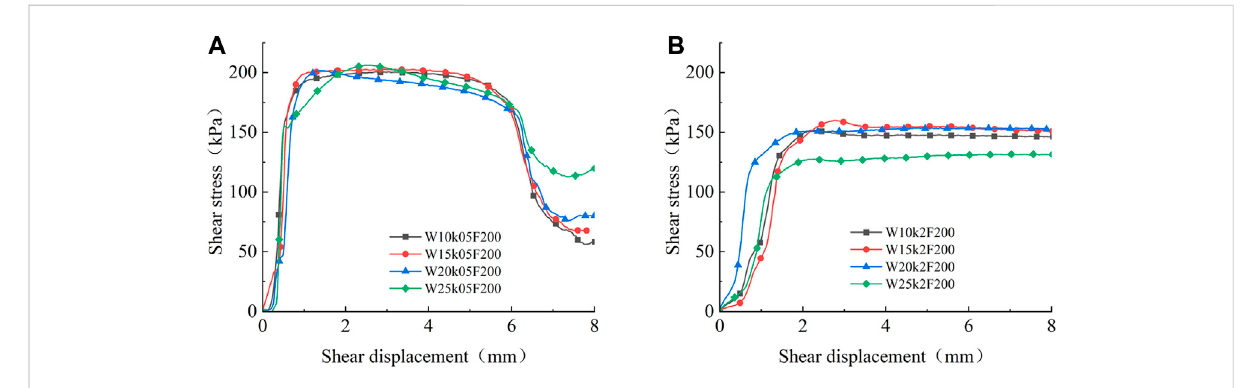
FIGURE 6 Shear stress – displacement curve under different moisture contents: (A) k = 0.5, F = 200 kPa; (B) k = 2.0, F = 200